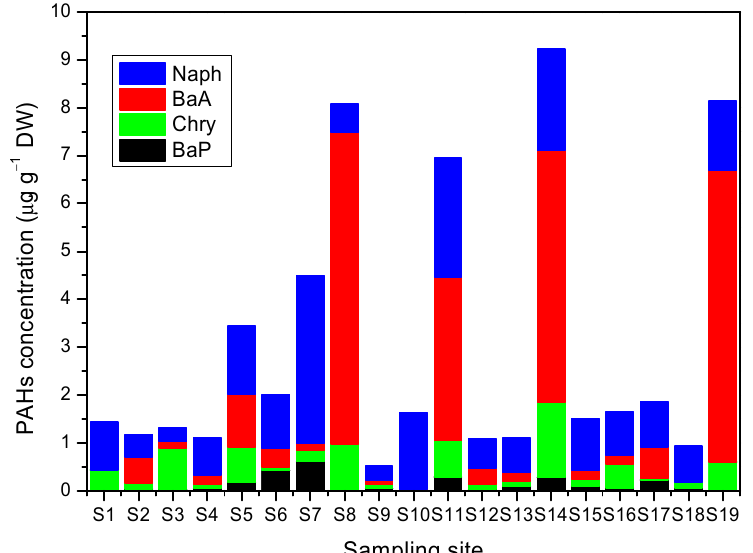
Figure 3. Total and individual concentration of PAHs in needle samples at all sites studied.